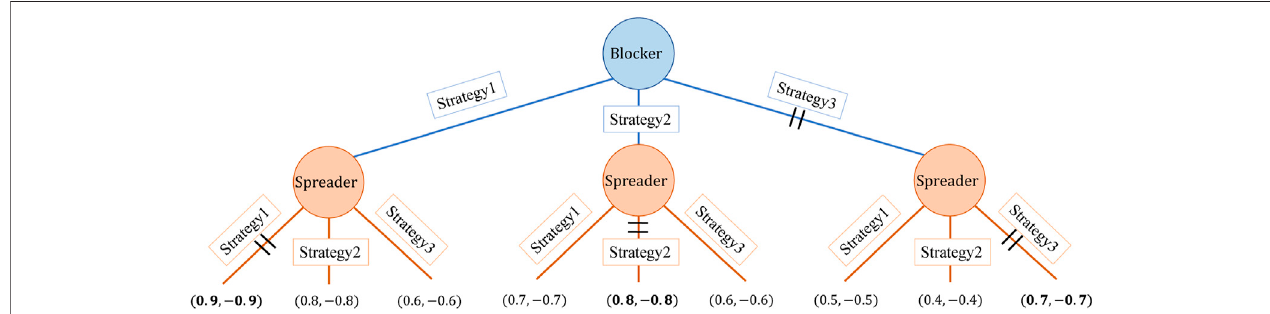
FIGURE 1 | Diagram of backward induction tree solving dynamic equilibrium process.